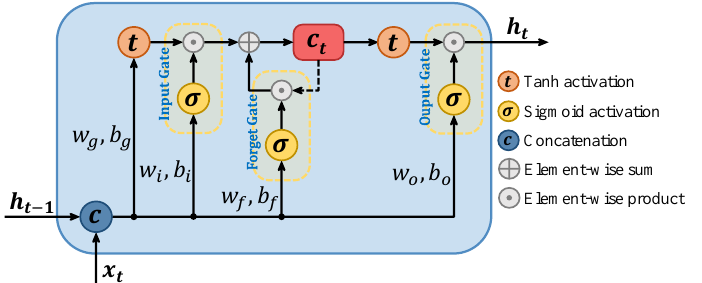
Figure 2. Structure of LSTM